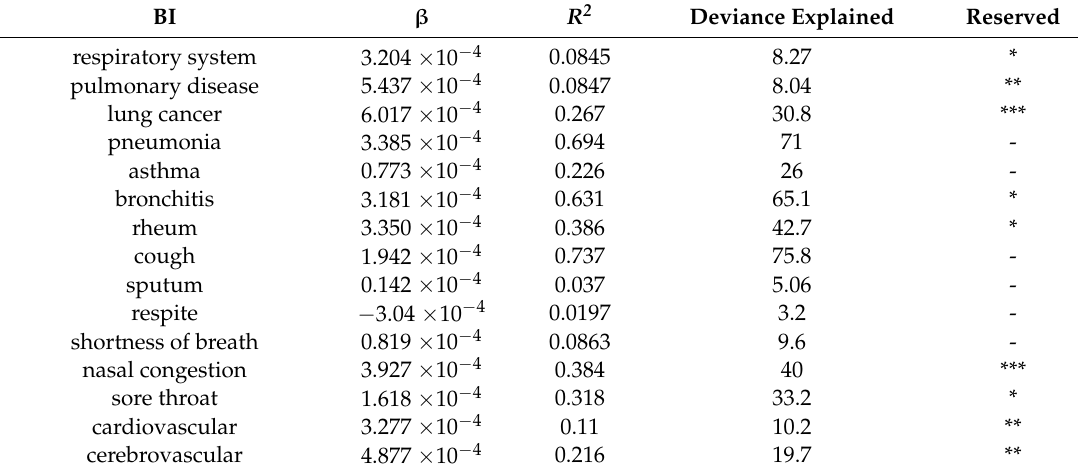
Table 6. Results with GAM considering a three-day lag, with AQI (and IAQI) as explanatory variables and Baidu indices (BIs) as response variables. The indices marked by “-“ indicate insignificance and were removed; the number of asterisks indicates how well the index is explained by AQI (IAQI). BI β R